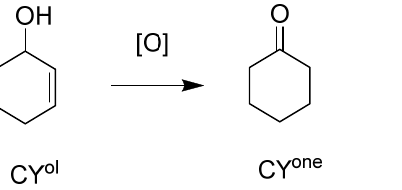
Figure 27. Cyclohexanol (CY ol ) oxidation and the studied Cyclohexanone (CY one ) product.